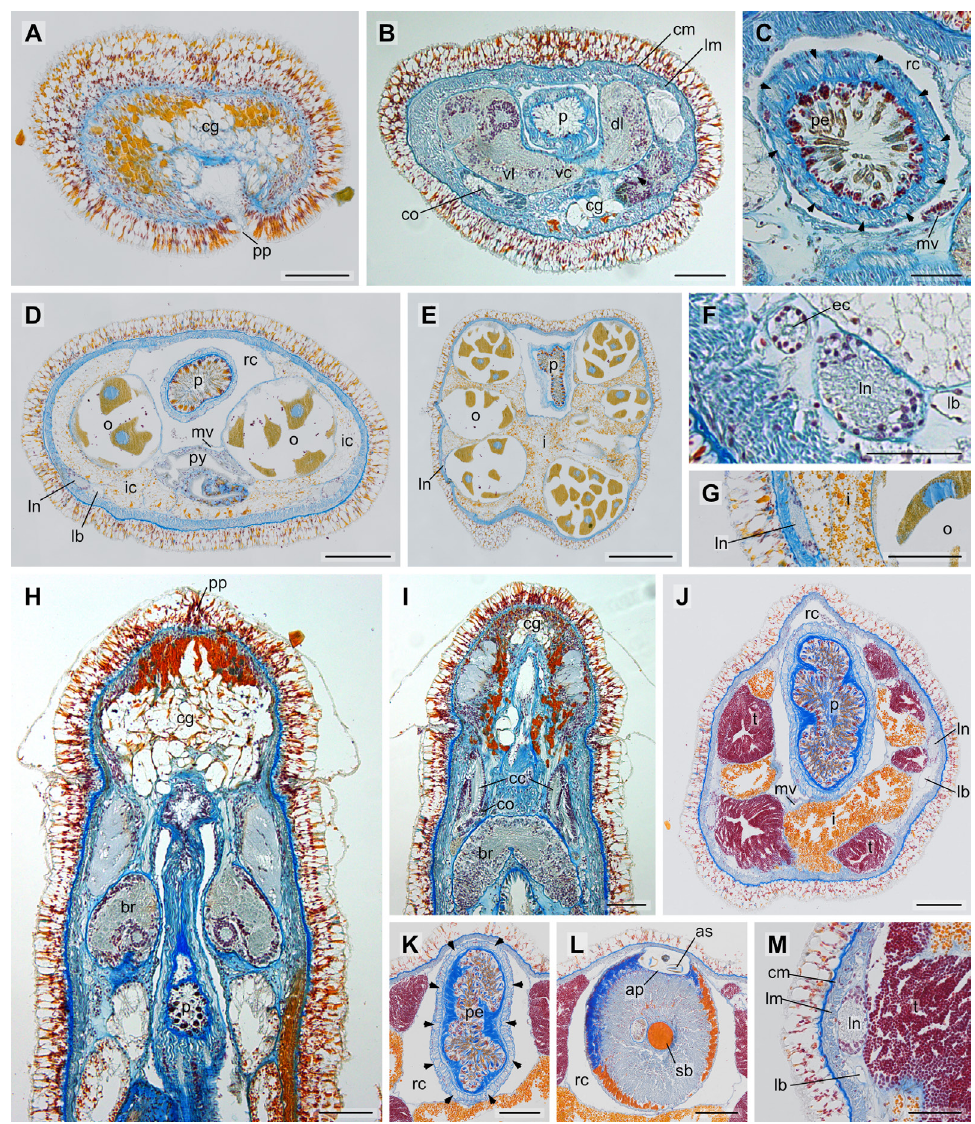
Fig. 11. A–G . Tetrastemma sundbergi sp. nov., holotype (SIO-BIC N256), transverse histological sections. H–M . Tetrastemma strandae sp. nov., holotype (SIO-BIC N285), horizontal histological sections (H–I) and transverse histological sections (J–M). A . Anterior tip of head with proboscis pore. B . Brain region with well-visible cerebral canal (arrowhead). C . Proboscis with 10 proboscis nerves (arrowheads) in stomach region. D . Pyloric region. E . Intestinal region with ovaries. F . Anterior part of lateral nerve cord. G . Posterior part of lateral nerve cord located in body wall musculature. H . Longitudinal section through anterior tip with proboscis pore. I . Longitudinal section through the ventral part of the anterior tip. J . Intestinal region with testes. K . Proboscis in stomach region with 10 proboscis nerves (arrowheads). L . Proboscis armature. M . Lateral nerve cord in intestinal region. Abbreviations: ap = accessory stylet pouch; as = accessory stylet; br = brain; cc = cerebral canal; cg = cephalic glands; cm = circular muscle layer; co = cerebral organ; dl = dorsal brain lobe; ec = excretory canal; i = intestine; ic = intestinal cecum; lb = lateral blood vessel; lm = longitudinal muscle layer; ln = lateral nerve cord; mv = mid-dorsal-vessel; o = ovary; p = proboscis; pe = proboscis epithelium; pp = proboscis pore; py = pylorus; rc = rhynchocoel; sb = stylet basis; t = testis; vc = ventral commissure; vl = ventral brain lobe. Scale: 100